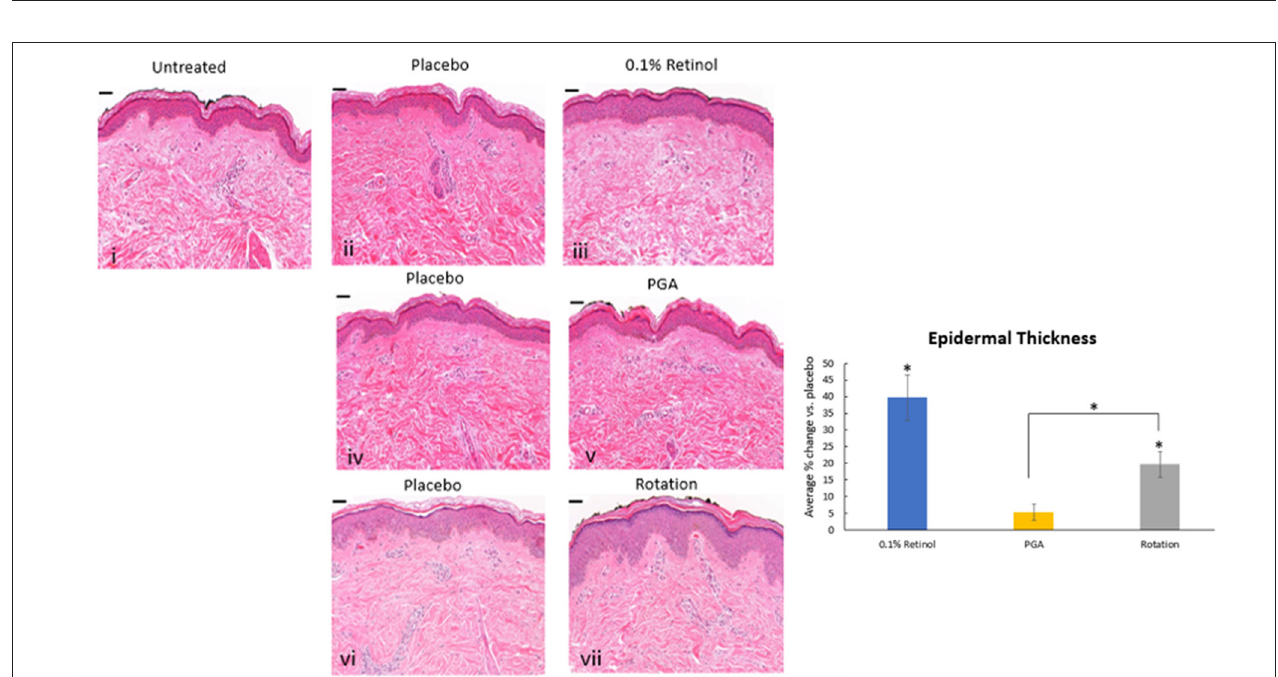
FIGURE 7 | Histology of skin biopsies. Volunteers ( n = 32) received application of either 0.1% retinol formulation for 4 weeks or weekly rotation of 1% phytol/4% glycolic acid (PGA) formula with 0.1% retinol formula. Biopsy samples were taken at the end of the 4-week period. An analysis of epidermal thickness in in vivo skin samples by H&E staining showed that retinol and rotational formulations have a significant effect on increasing epidermal thickness when compared to placebo ( p < 0.05). i: untreated, ii: placebo for retinol, iii: retinol, iv: placebo for PGA, v: PGA, vi: placebo for vii, and vii: rotation of iii and v. Scale bar = 50 µ m. *Means p < 0.05 or statistically significant